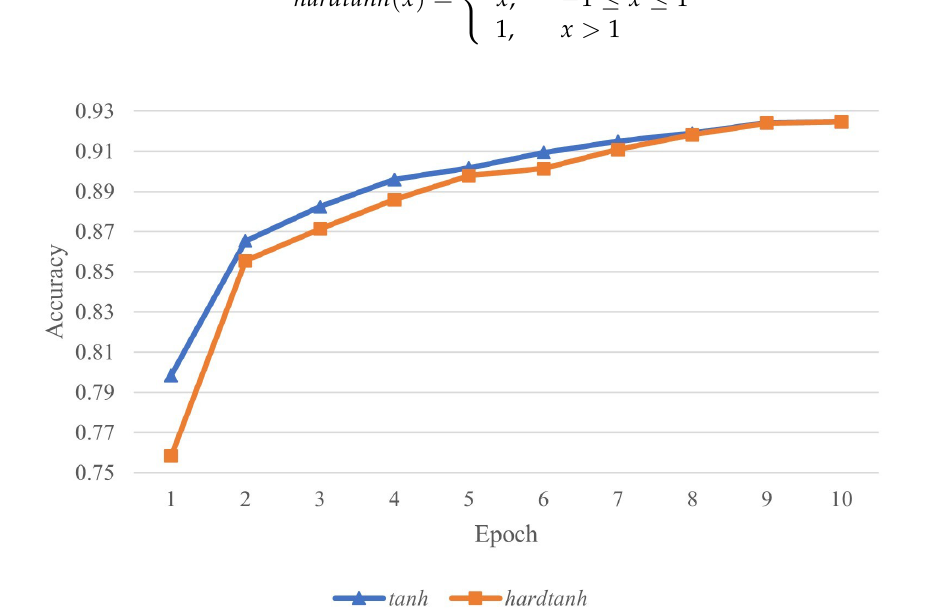
Figure 5. Comparison between tanh and hardtanh in terms of training time and model’s